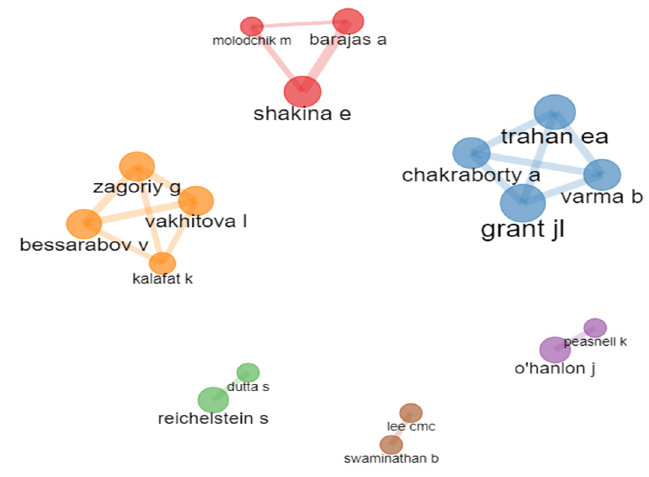
Figure 5. Visual Map of Prominent Authors’ Collaboration on EVA Research.